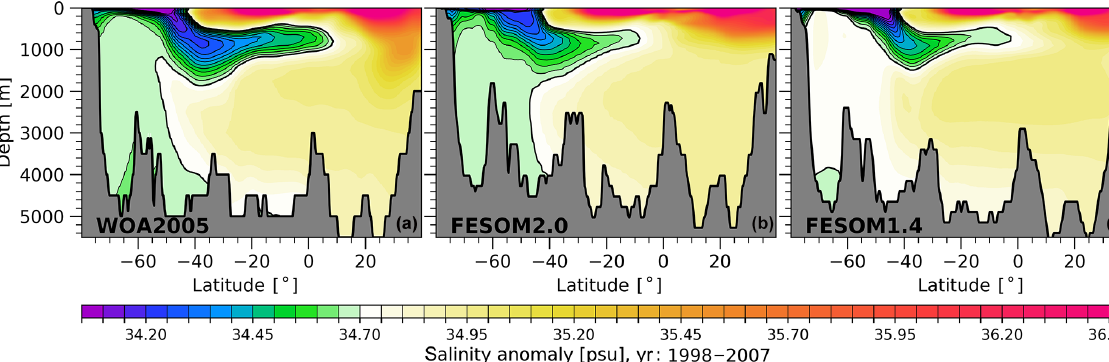
Figure 18. Mean salinity in the vertical section from − 80 ◦ S, − 30 ◦ W, to 40 ◦ N, − 30 ◦ W: WOA05 (Locarnini et al., 2006; Antonov et al., 2006) annual climatology (a) , FESOM2.0 (b) and FESOM1.4 (c) . Model results are averaged for the period of 1998–2007. Contour lines highlight the spreading of Antarctic Intermediate Water ( < 34.70psu)